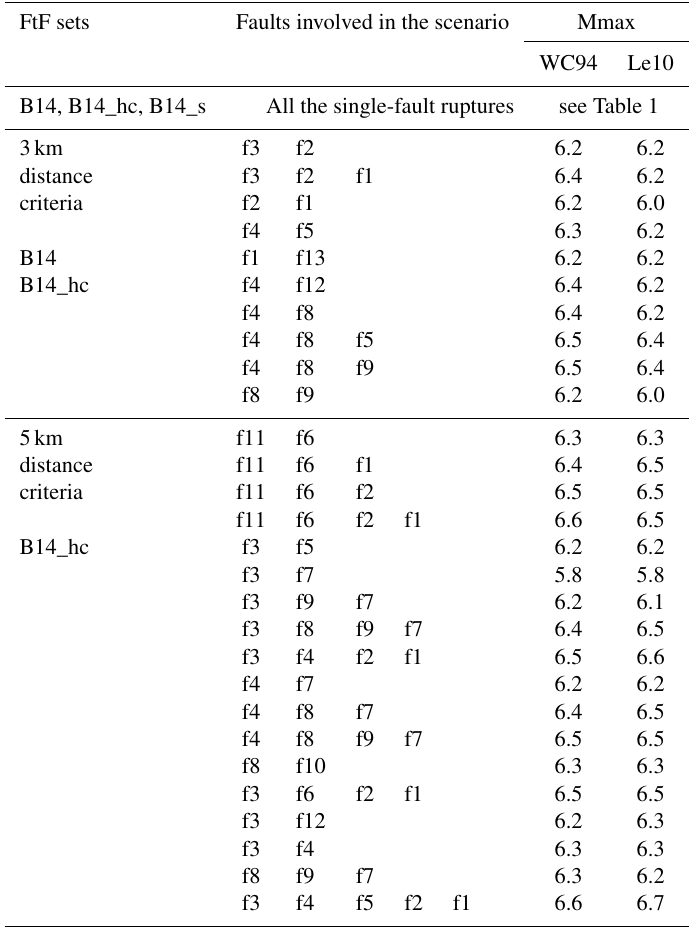
Table 2. Rupture scenarios considered in each model. Branch B14_s considers only the single-fault ruptures. Branch B14 considers the single-fault ruptures and the FtF ruptures with a 3km distance criteria. Branch B14_hc considers the single-fault ruptures and the FtF ruptures with a 3 and a 5km distance criteria. Mmax values are calculated using the equations for normal faults based on the rupture area. WC94: Wells and Coppersmith (1994); Le10: Leonard